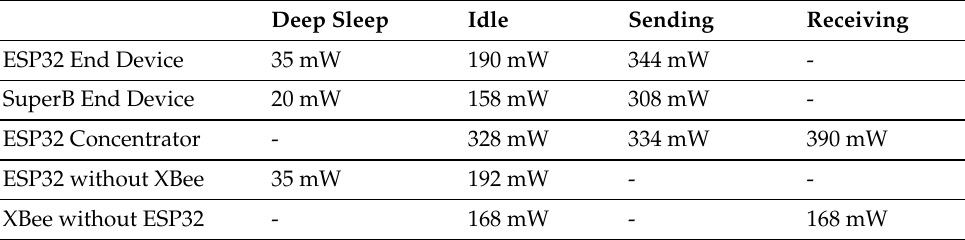
Table 3. Energy Consumption based on Device Type and